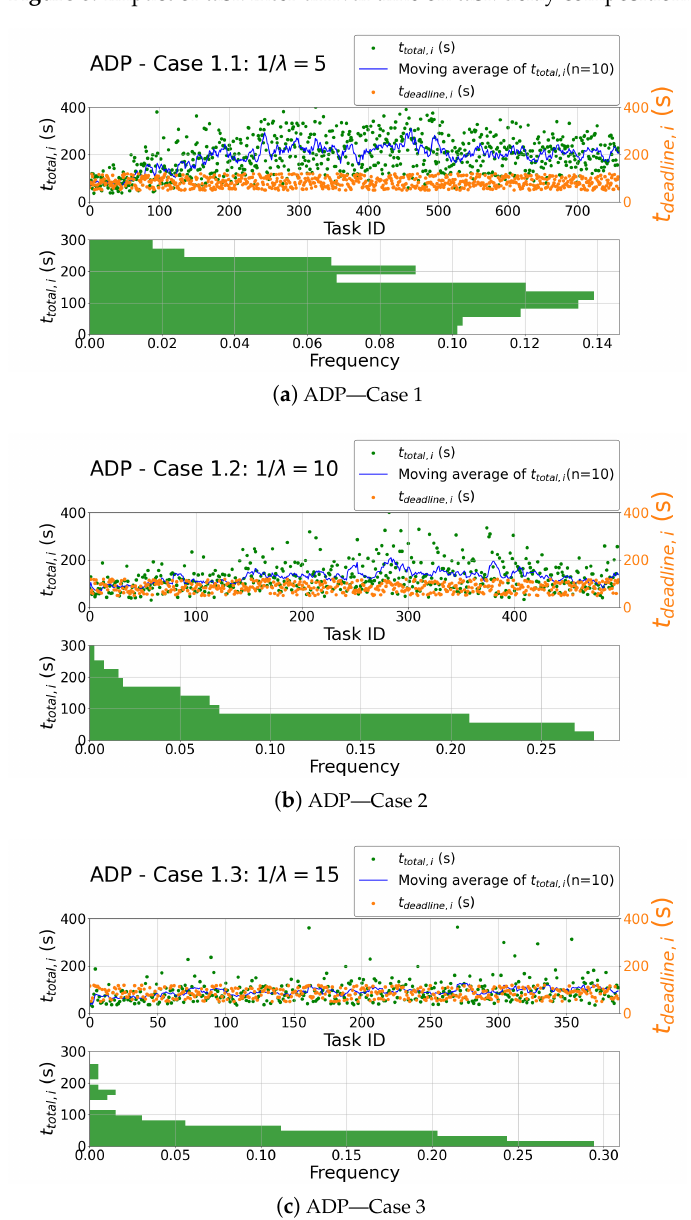
Figure 9. System delay and deadline distribution for